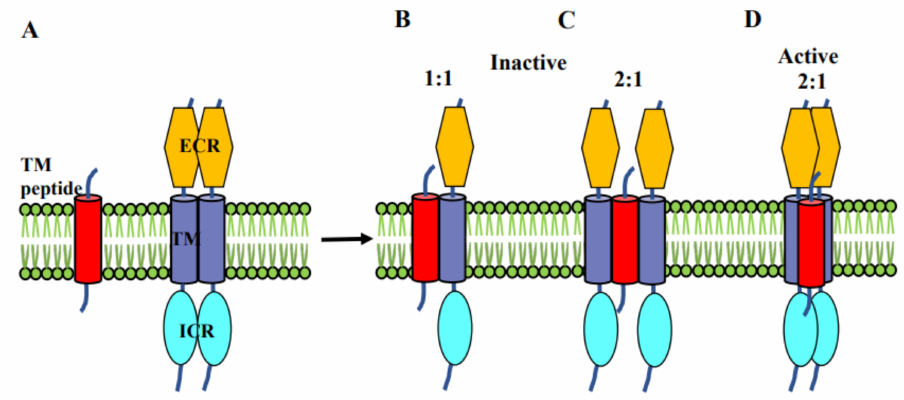
Figure 4. Schematic representing the association of inhibitor/activator peptides with Eph receptor dimer showing the involvement of TM domains ( A ). ( B , C ) Inhibitor peptide breaks the receptor dimerization and makes either 1:1 or 2:1 (receptor: peptide) interaction and thereby inactivating the receptor whereas ( D ) the activator peptide associate with the receptor dimer in 2:1 (receptor: peptide) fashion without breaking the TM